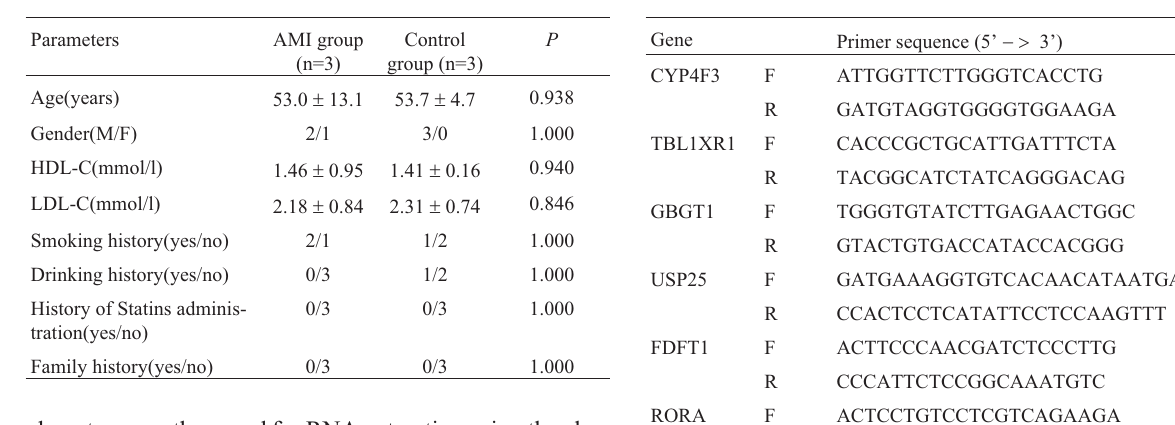
Table 2 - Primer sequences for fluorescence quantitation.